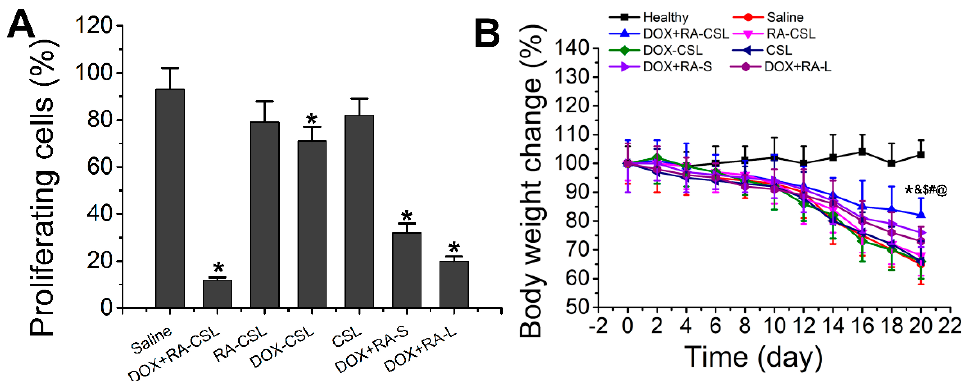
Figure 5. ( A ) Quantitative analysis of Ki67-positive cells in tumor tissues of mice after various treatments; ( B ) temporal change in the body weight of mice receiving different treatments. Data are shown as mean ± SD ( n = 4). * p < 0.05 vs. Saline group, & p < 0.05 vs. DOX+RA-L, $ p < 0.05 vs. DOX-CSL, # p < 0.05 vs. RA-CSL, @ p < 0.05 vs. Healthy group. CSLs: chondroitin sulfate liposomes; RA-CSLs: retinoic acid-loaded CSLs; DOX-CSLs: doxorubicin-loaded CSLs; DOX+RA-S: DOX/RA solution; DOX+RA-Ls: liposomes co-loaded with DOX and RA; DOX+RA-CSLs: CSLs co-loaded with DOX and RA.